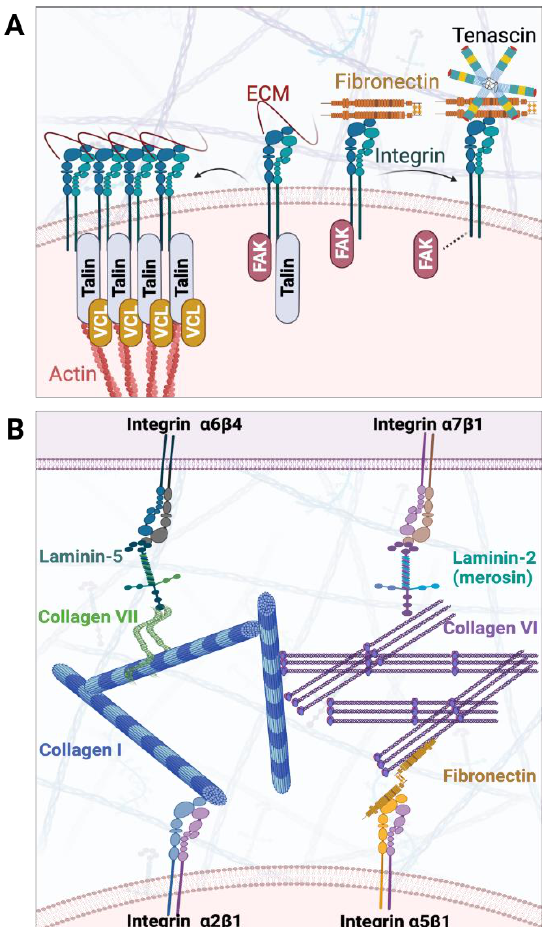
Figure 4. Schematic diagram of ECM components dysregulating ENS development in HSCR from genetic studies. ( A ) Focal adhesion kinase (FAK) involves in the intracellular signalling cascade initiated by activation of integrins. FAK promotes the recruitment of talin, and vinculin (VCL) can then bind to integrin-bound talin to crosslink actin to regulate the signal transduction from the ECM to the actin cytoskeleton. Integrins with RGD domain can bind fibronectin and the binding of tenascin inhibits fibronectin-induced integrin signalling. ( B ) Impaired Cell-ECM interaction in HSCR patients involving collagens, laminins, and integrins. Adhesion to collagen I can be mediated by integrin α2β1. Integrin α5β1 can attach to collagen VI via fibronectin. Laminin, which play as a major component of the basal lamina, can promote cell motility. Cross-talk between collagens and laminins is found in collagen VI and laminin-2, as well as collagen VII and laminin-5 (created with BioRender.com).